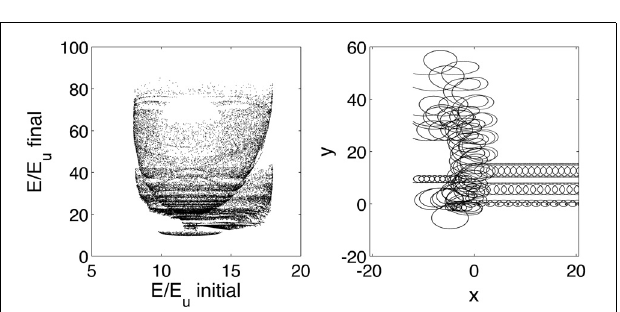
FIGURE 8 | Left: Initial vs. final energies for pickup ions. Right: energy spectrum upstream (stars) and downstream (circles). For the shock with θ = 70 ◦ , s = 0 . 5, and D = 0 . 1.